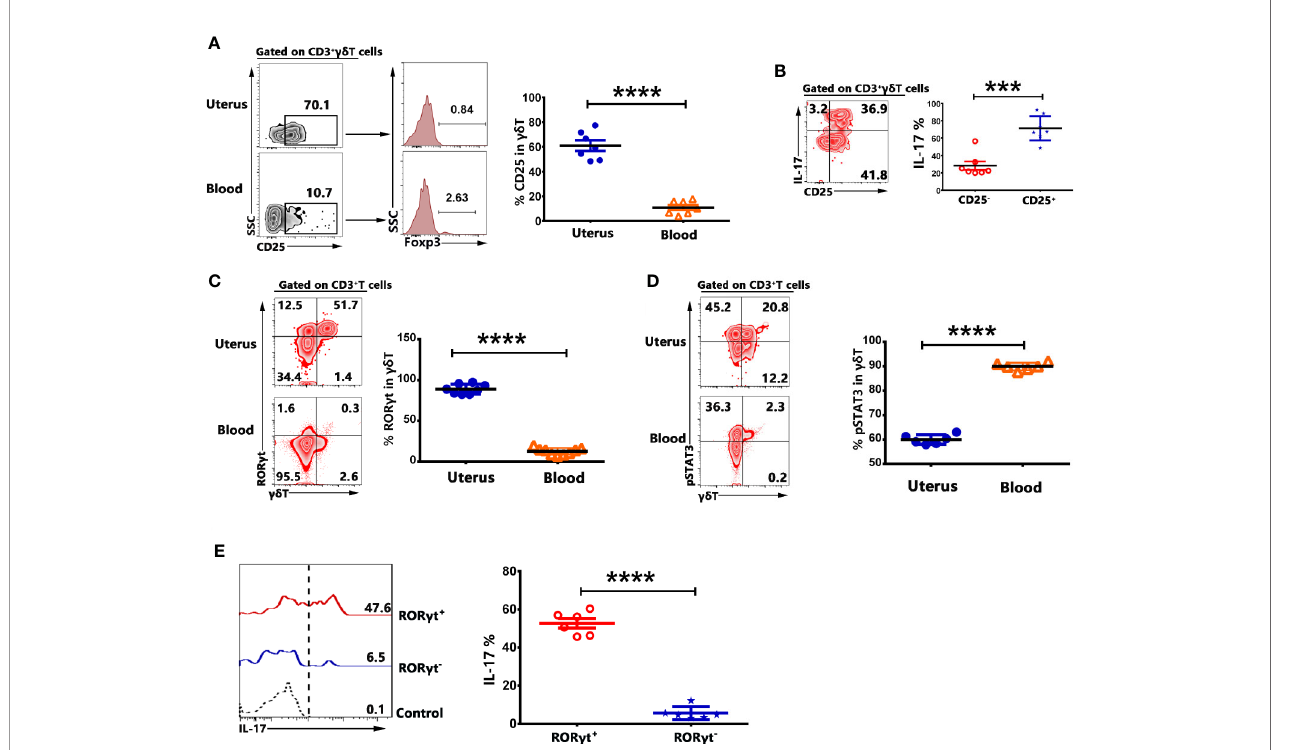
FIGURE 6 | gd T cells in uterus expressed CD25 and transcription factors ROR g t. The expression of CD25 and transcription factor Foxp3 on gd T cells from uterus and blood were assessed by FACS. Gated on gd T cells, the representative graph and statistical results for the expression of CD25 and Foxp3 were shown (A) . The mononuclear cells from uterus and blood were stimulated with or without PMA plus ionomycin in the presence of BFA for 6 h. The expression of IL-17 by CD25 + and CD25 − gd T cells was analyzed and the representative graph as well as summary data were shown (B) . The expression of ROR g t (C) and pSTAT3 (D) on gd T cells from uterus and blood was shown. The expression of IL-17 by ROR g t + and ROR g t - gd T cells was analyzed and the representative graph and summary data were shown (E) . Data were expressed as the mean ± SEM, and each dot represented one independent experiment with six mice. The statistical signi fi cance was determined with the Mann – Whitney U test. ***P < 0.001 and ****P <